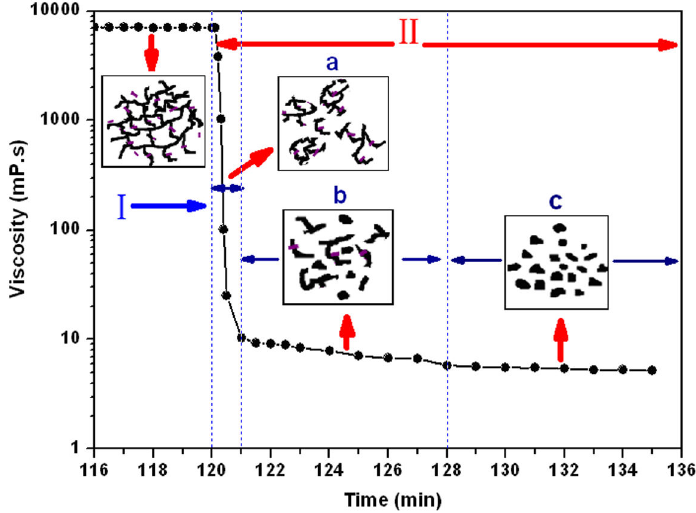
Figure 6. Viscosity changes during the DPG particle preparation process. a) Broken rounded period; b) Further milling period; c) Particle homogeneous period. doi: